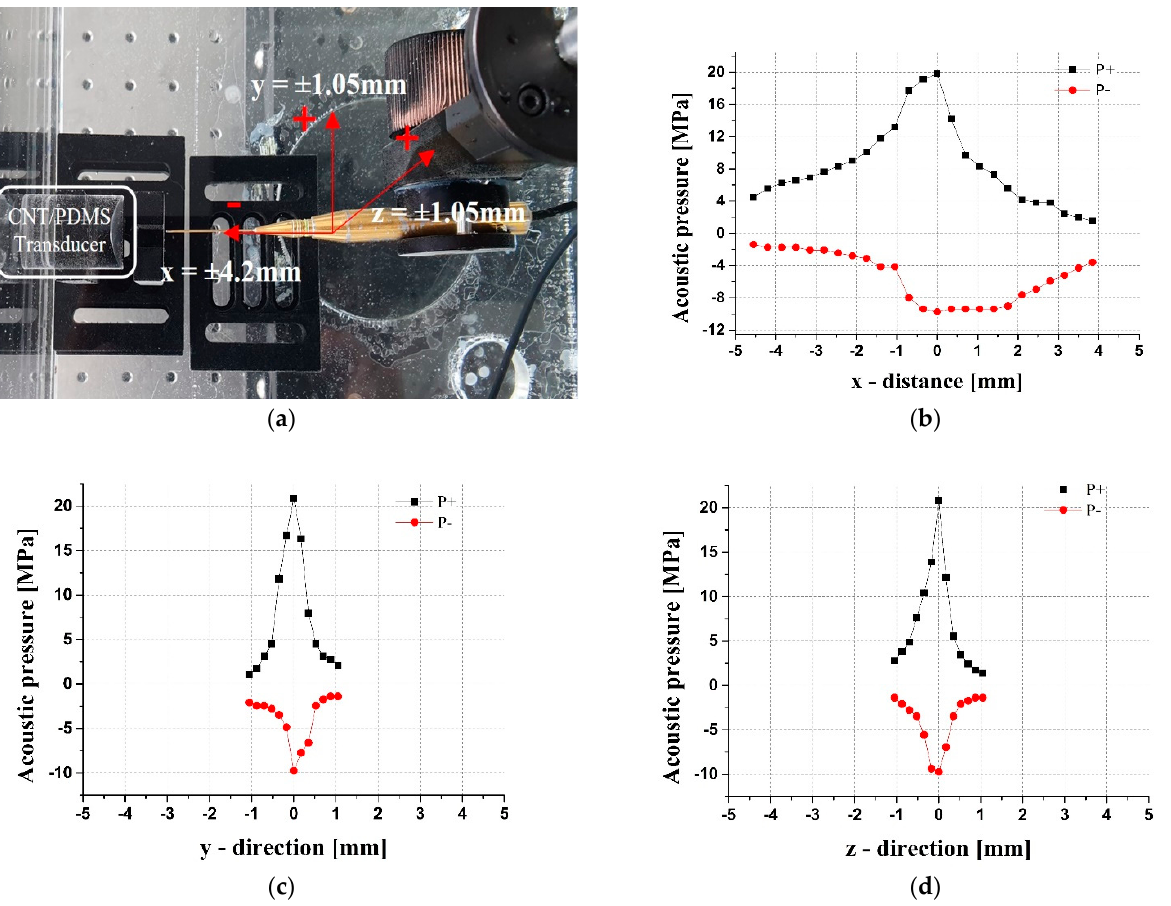
Figure 4. ( a ) Experimental setup for measuring the focal point of the shock wave. The focal point was at 0 mm. ( b ) The peak positive and negative pressures were observed at 0 mm with reference to the focal point along the axial direction. ( c ) The peak pressures were observed at 0 mm with reference to the focal point along the y-direction. ( d ) The peak pressures along the z- direction were also observed at 0 mm with reference to the focal point.